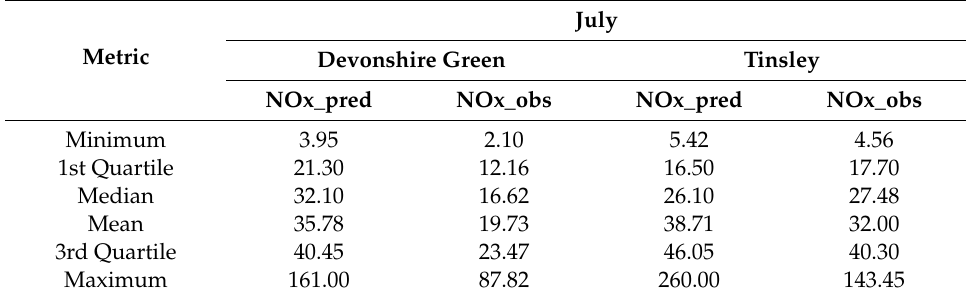
Table 6. Summary of the observed and predicted NOx concentrations ( µ g / m 3 ) in July at Devonshire Green and Tinsley monitoring stations.